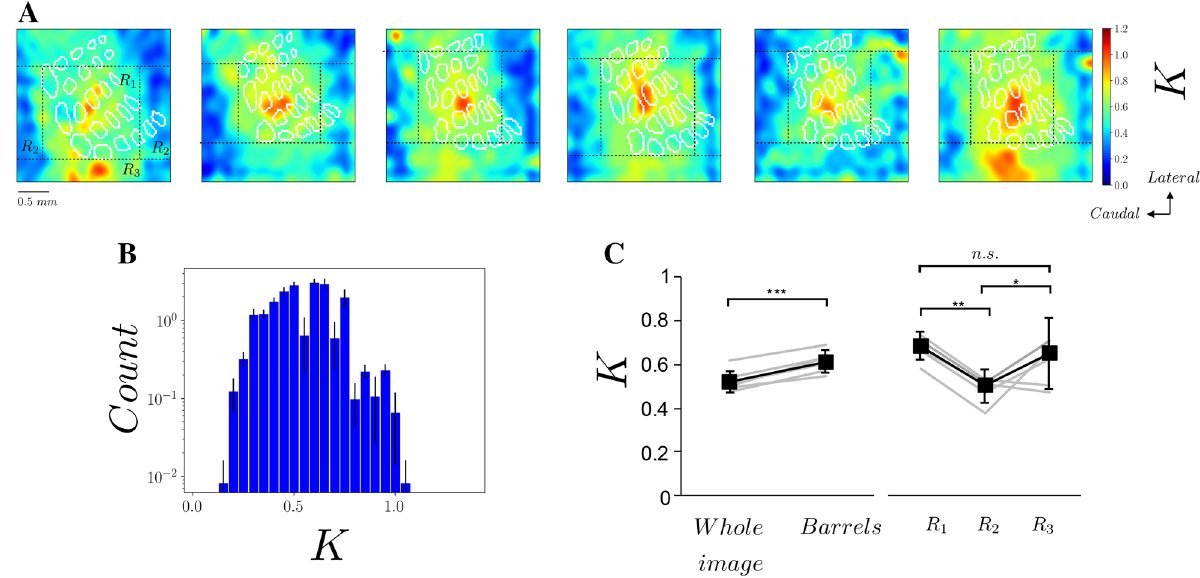
Figure 5. Couplings reconstructed from experimental VSD imaging data. (A) The reconstructed spatial distribution of K for 6 different mice. The dashed lines are estimated based on the spatial location of histologically reconstructed barrels for each mouse. Horizontal dashed lines correspond to the lateral border of the α barrel and medial border of the δ barrel, respectively. Vertical dashed lines correspond to the caudal border of the α barrel and rostral border of the D4 barrel, respectively. Three regions R 1,2,3 are defined from these landmarks. Notice that, as explained in the main text, our inversion procedure does not take into account spatial locations higher than the A4 whisker representation, where the activity appears clearly influenced by S2. ( B) Histogram of the values of K reconstructed with the inversion method. The values are mean (+ /− standard deviation) over the 6 mice. ( D) Mean K values computed over 5 different regions for the 6 mice (individual values in grey, mean + /− standard deviation over the 6 animals in black). Whole image stands for the mean over the whole field of view, Barrels stands for the mean computed over the pixels located inside the delimited barrels, *** P < 0.001, (paired t-test). R 1,2,3 stands for the mean over the region R 1,2,3 as shown in A, ** P < 0.01, * P < 0.05, n.s. non significan (one way repeated measures analysis of variance followed by an all pairwise multiple comparison procedure (Holm–Sidak